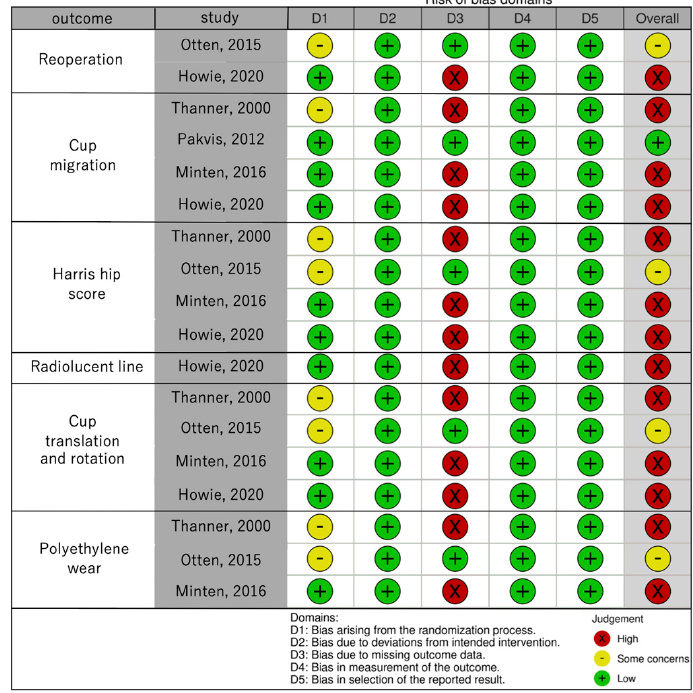
Figure 1. PRISMA flow diagram of the literature results. (CENTRAL: the Cochrane Central Register of Controlled Trials; ICTRP: the World Health Organization International Clinical Trials Registry Platform).